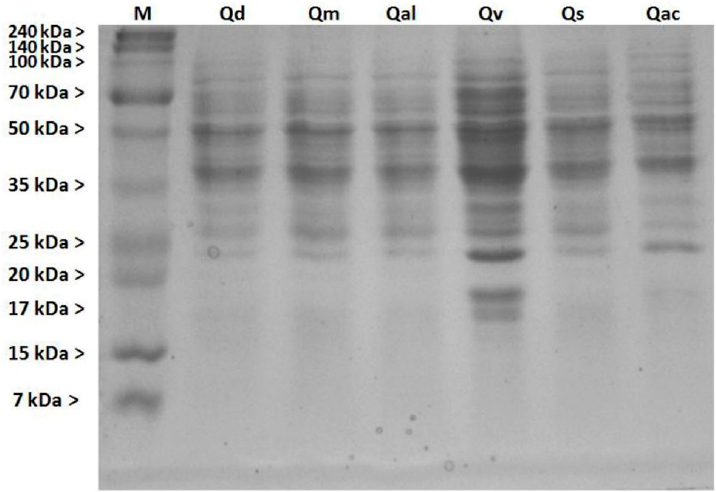
Figure 8. Coomassie blue-stained SDS-PAGE containing protein extracts in Quercus